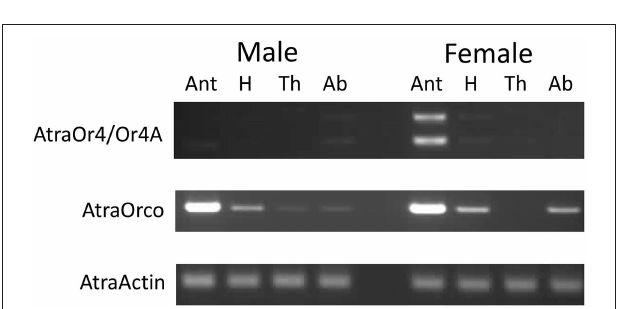
FIGURE 4 | AtraOR4 and AtraOR4A expression profile in cDNA prepared from total RNA extracted from male and female antennae (Ant), heads (H), thoraces (Th) and abdomens (Ab). Top : Detection of AtraOR4 and AtraOR4A using transcript specific primers in reverse transcription PCR (RT-PCR) reactions. Middle : Detection of AtraOrco using specific primers in RT-PCR reactions. Bottom : Detection of AtraActin using specific primers in RT-PCR reactions. For each panel, PCR products were visualized on 1.5% agarosegelsbyethidiumbromidestainingandUVillumination.Bandsproduced were of the size predicted for the transcript specific primer